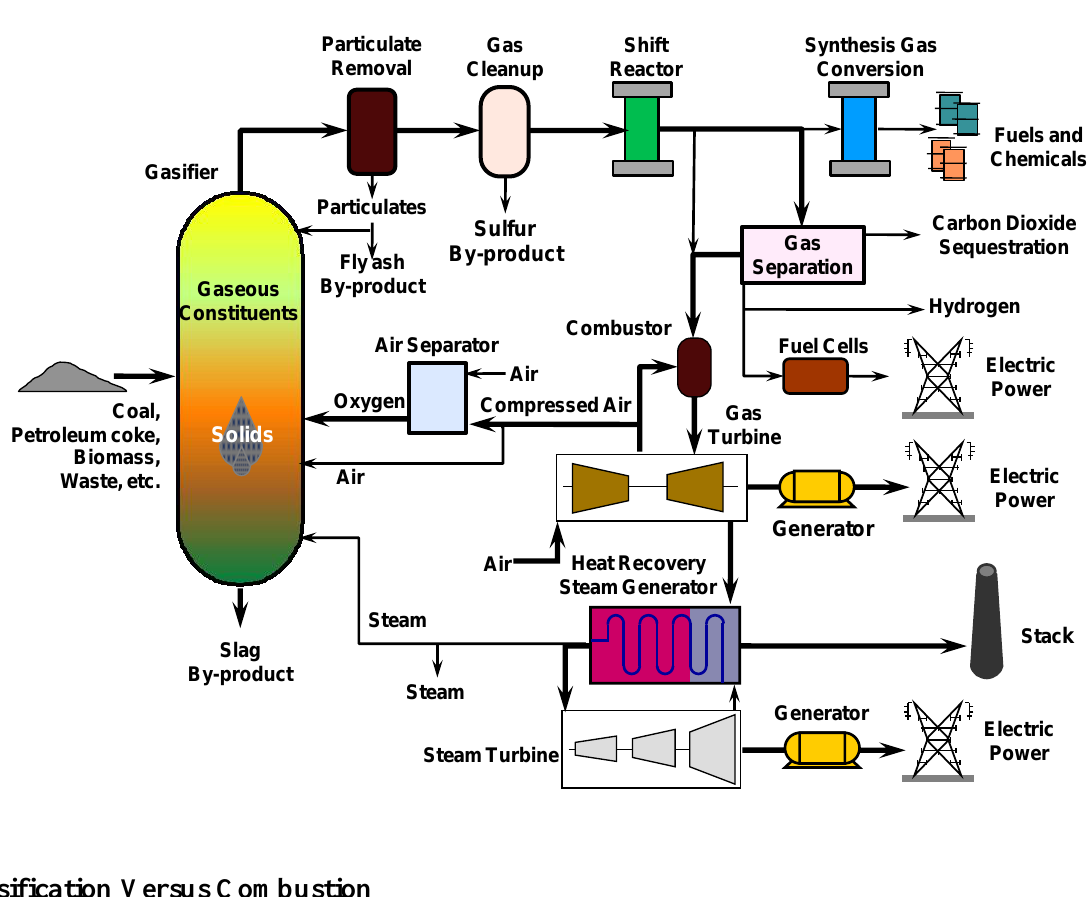
Figure 5. Poly-generation plant